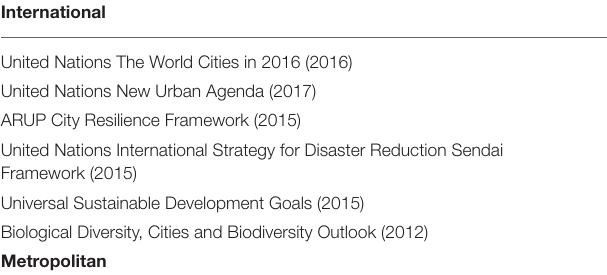
TABLE 1 | Relevant influential international, metropolitan, and local UHI and urban expansion policies, strategies, and assessments (with publication date) referred to in this